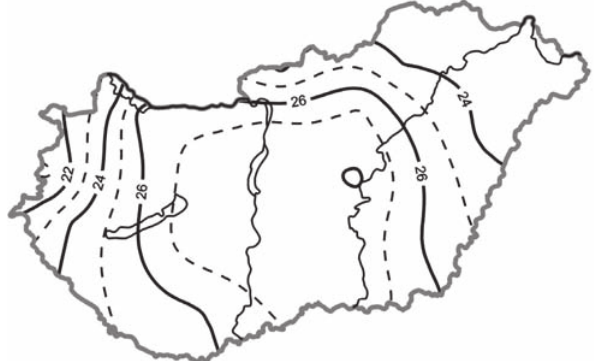
Figure 5 – Mean values of the coeffi cients of variation of absolute temperature minima in winter measured at 16 stations over a period of 1951–2010